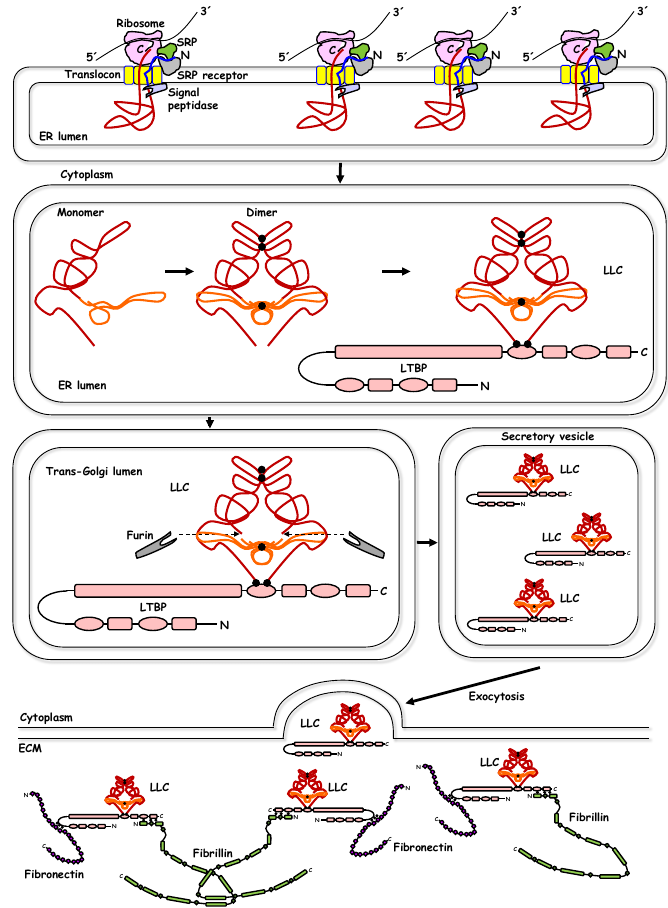
Figure 1. Biosynthesis and extracellular deposition of transforming growth factor-β (TGF-β). A sequence of biochemical events is shown from the top left to the bottom, guided by black arrows. Ribosomes attached to the endoplasmic reticulum (ER) translate the TGF-β mRNA (black line 5′- 3’) into TGF-β protein (red line with blue signal peptide). The signal peptide associates with the signal recognition protein (SRP), which associates with the SRP receptor and the translated polypeptide is transported through the translocon channel into the lumen of the ER where the signal peptidase cleaves the signal peptide, generating a pro-TGF-β monomer that folds in the lumen of the ER (red polypeptide corresponds to the N-terminal long polypeptide known as latency associated peptide (LAP) and orange polypeptide correspond to the mature C-terminal polypeptide). The architecture of pro-TGF-β follows the crystallographic structure of the molecule. Dimerization of pro-TGF-β takes place in the ER lumen via three disulfide bonds (black dots), two in the prodomain and one in the mature domain. The dimeric pro-TGF-β crosslinks via disulfide bonds (black dots) to the latent TGF- β binding protein (LTBP) in the ER lumen, forming the large latent complex (LLC). The LLC translocates from the ER lumen to the cis- (not shown) and then to the trans-Golgi cisternae. For simplicity, the prodomain N-linked glycosylation is not shown. In the trans-Golgi, furin protease cleaves at the junction of the prodomain with the mature domain (dotted arrows). The cleaved LLC accumulates in secretory vesicles that undergo exocytosis and secrete the LLC to the extracellular environment where the LLC incorporates into the matrix (ECM). LLC crosslinking to fibrillin (three disulfide bonds, black dots) and to fibronectin (three more disulfide bonds, black dots) is shown. All relevant proteins are drawn emphasizing their domain architecture, without clarifying the identity of each